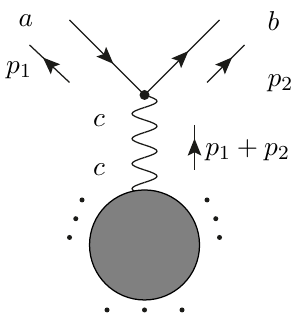
Figure 11 . Feynman diagrams leading to collinear gaugino